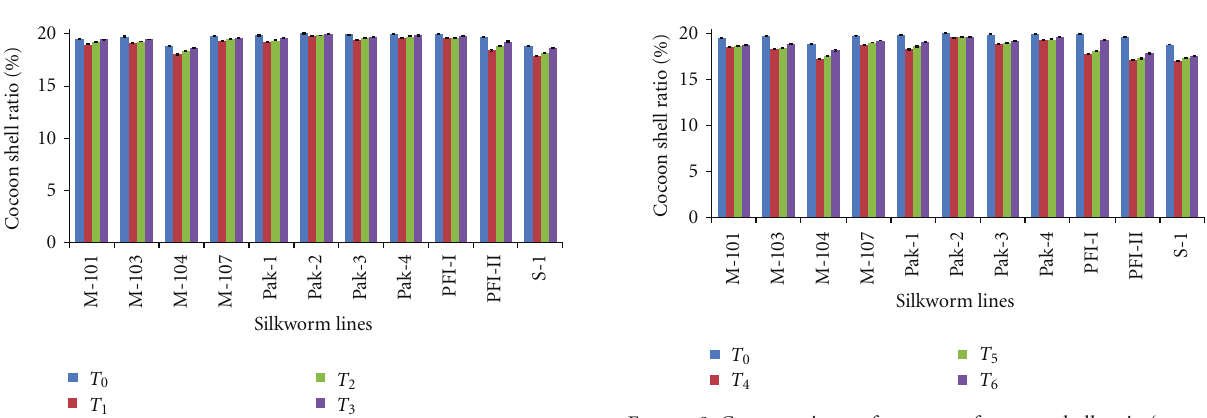
Figure 7: Comparative performance of cocoon shell ratio (mean ± SE) of eleven silkworm lines at 25 ± 1 ◦ C in combination with 55, 65, and 75% RH and controlled conditions of temperature and RH (25 ± 1 ◦ C and 70–80%, resp.).